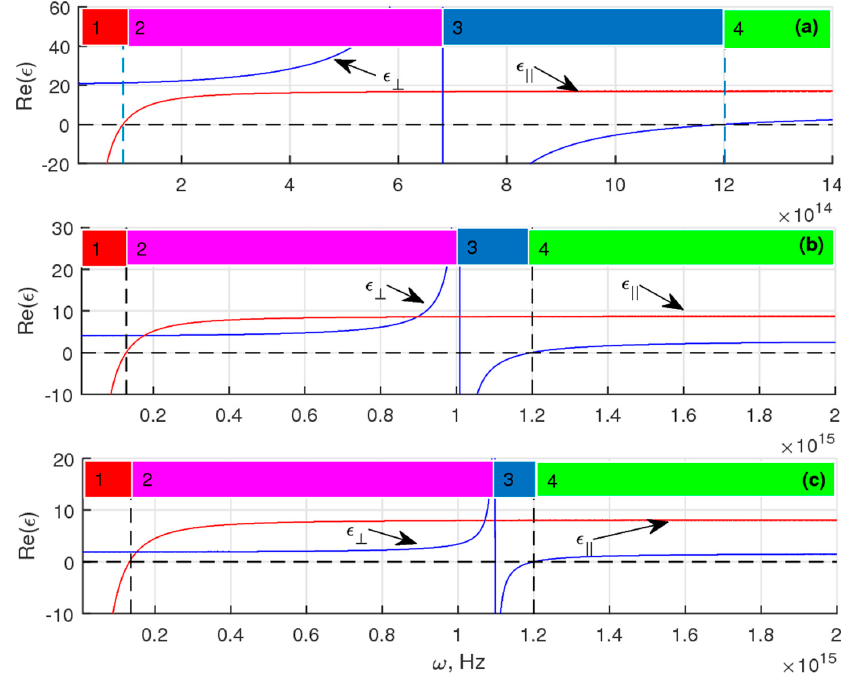
Figure 9. Real parts of ε ⊥ and ε || as a function of frequency. ε 1 = 18.8 in ( a ), ε 1 = 2.25 in ( b ), ε 1 = 1 in ( c ).